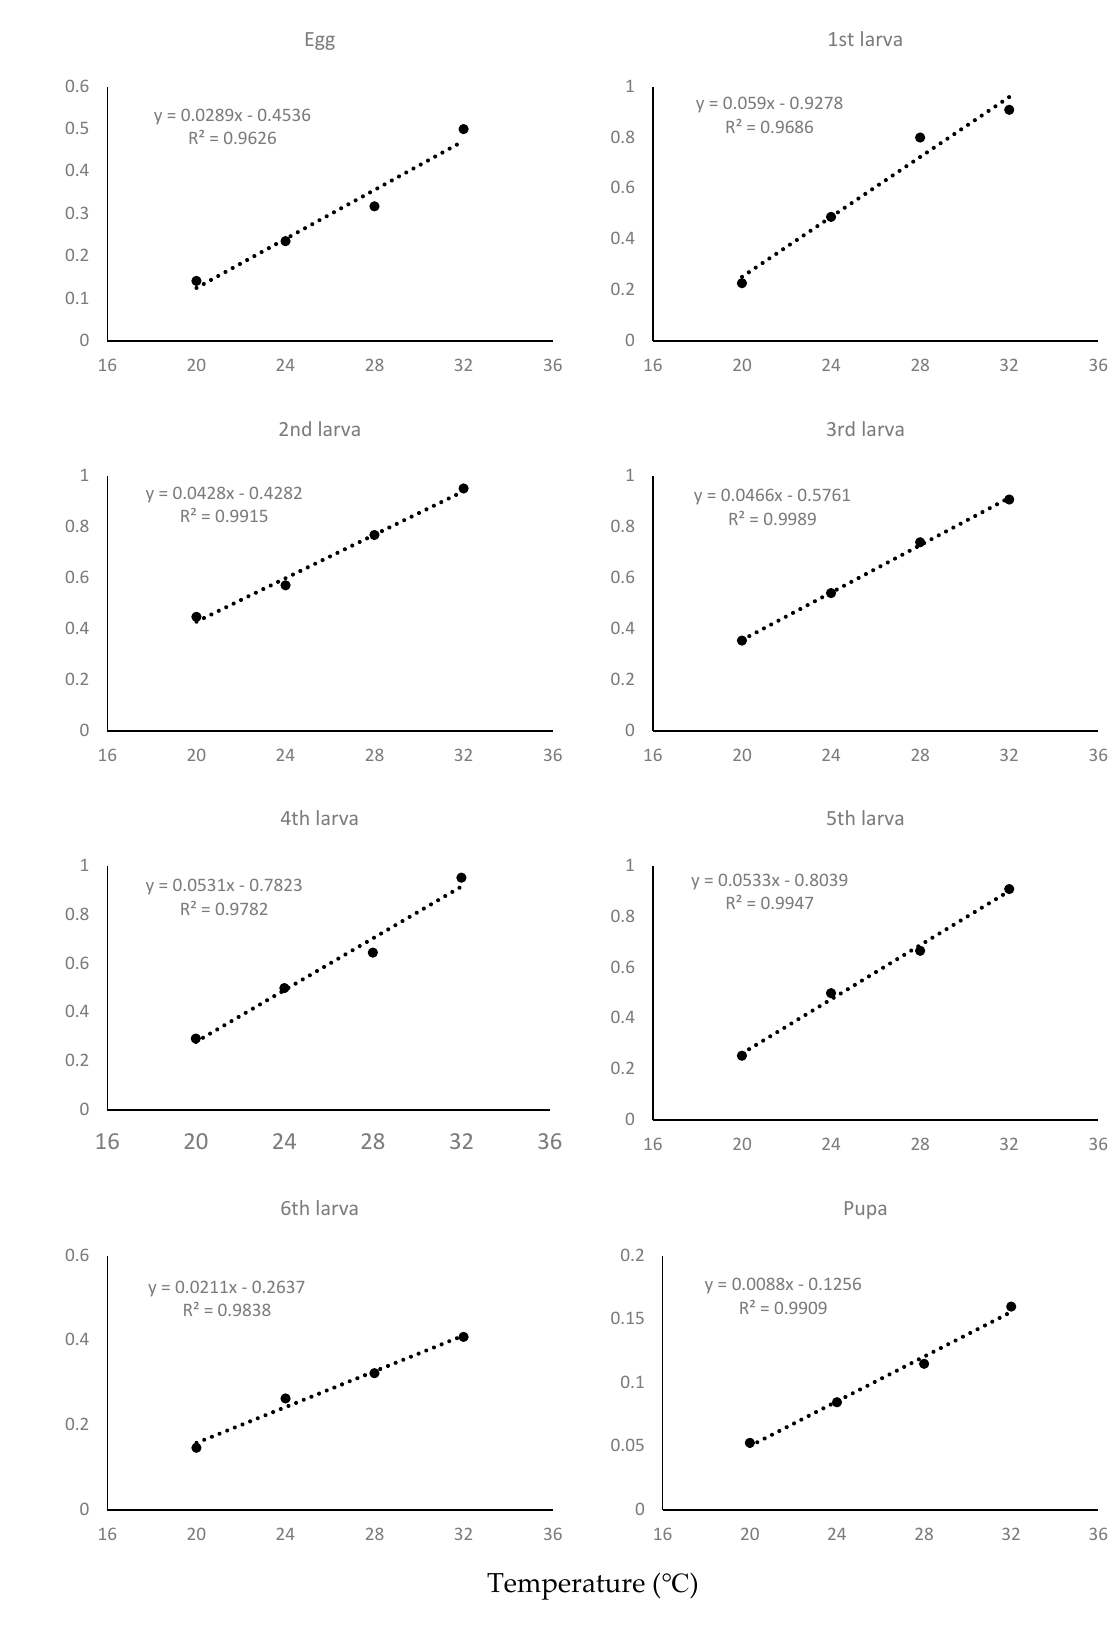
Figure 1. Liner regression analysis of temperature and growth of Spodoptera frugiperda (from egg to pupa).